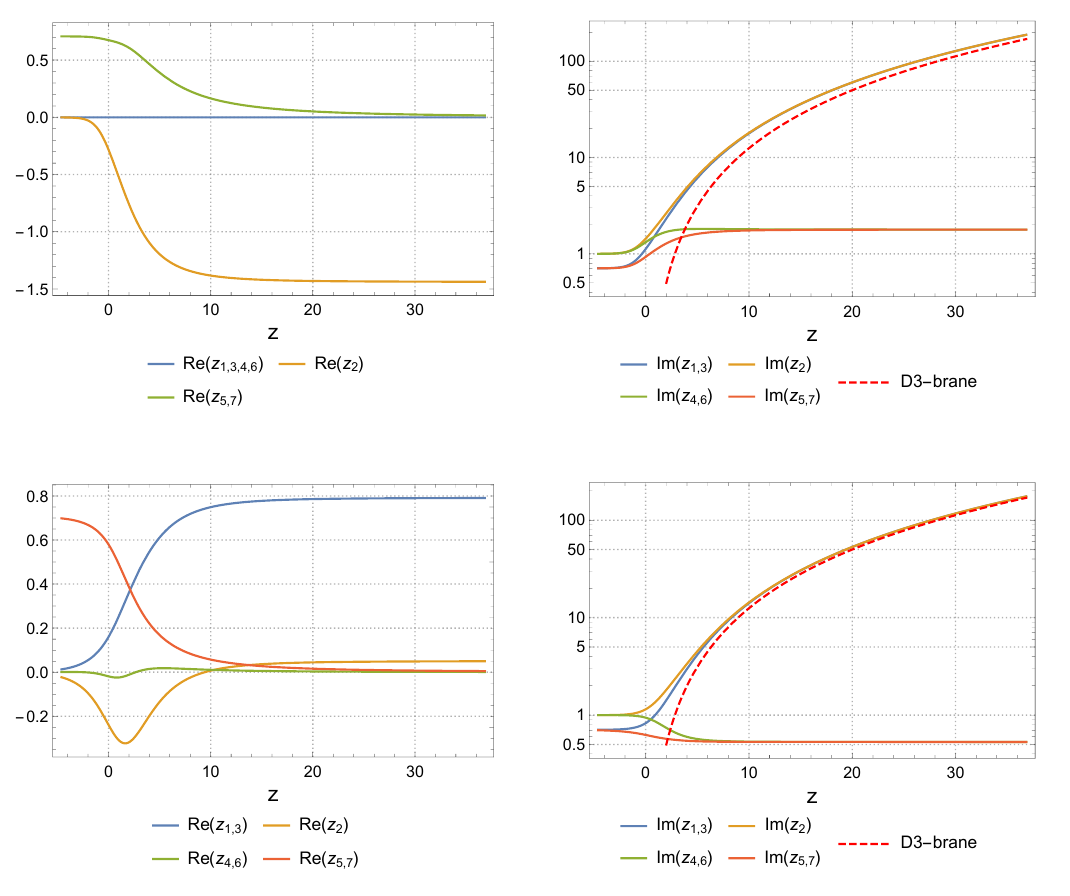
Figure 5 . Holographic RG flow from N = 4 SYM 4 (UV) to N = 2 & SU (2) J-fold CFT 3 (IR). Top plots: (Λ Λ ) = ( − 1 , 0 . 7) and ( λ 1 , 2 ( λ ) = (0 . 307 , 0 . 011) 1 , λ 2